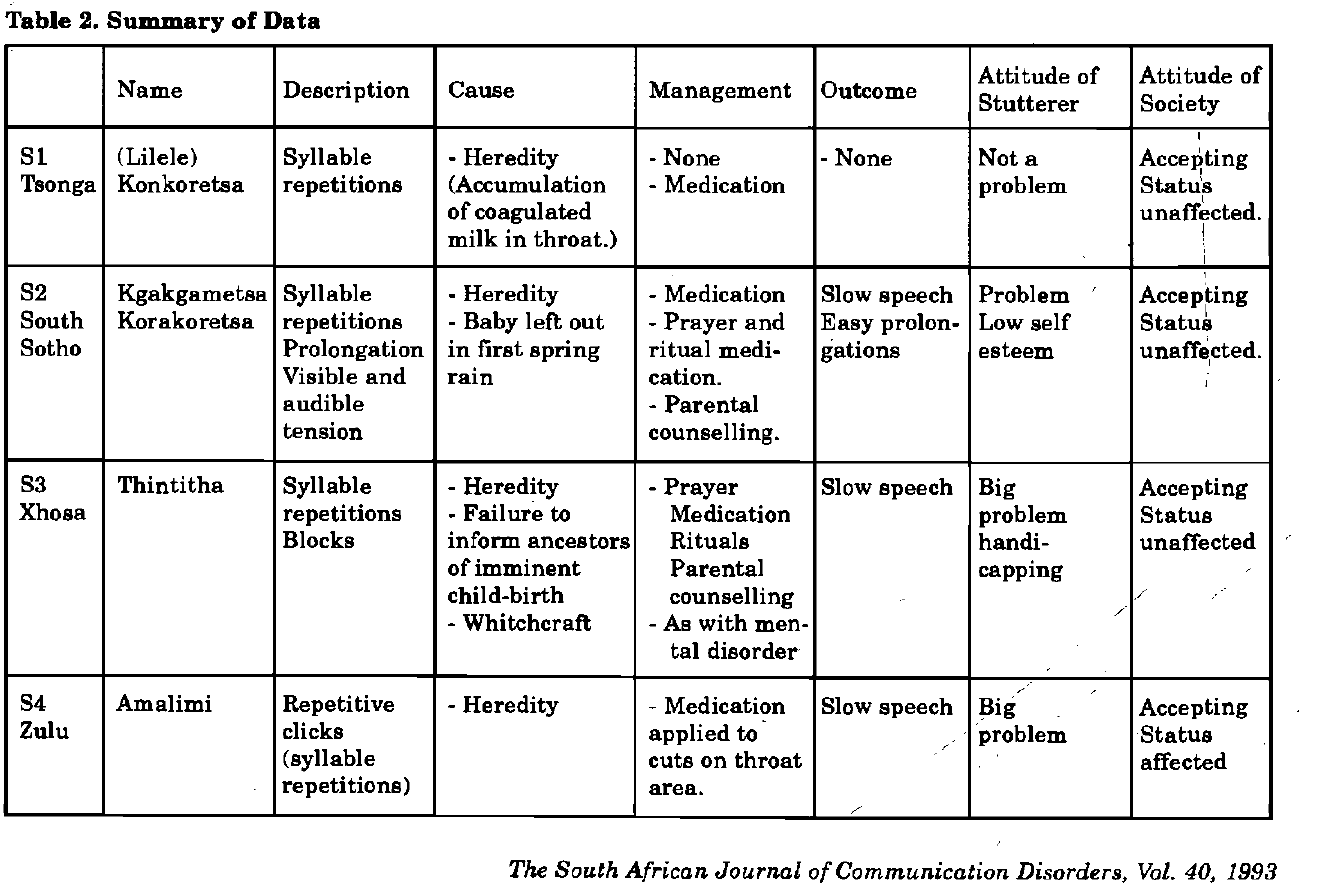
Table 2. Summary of